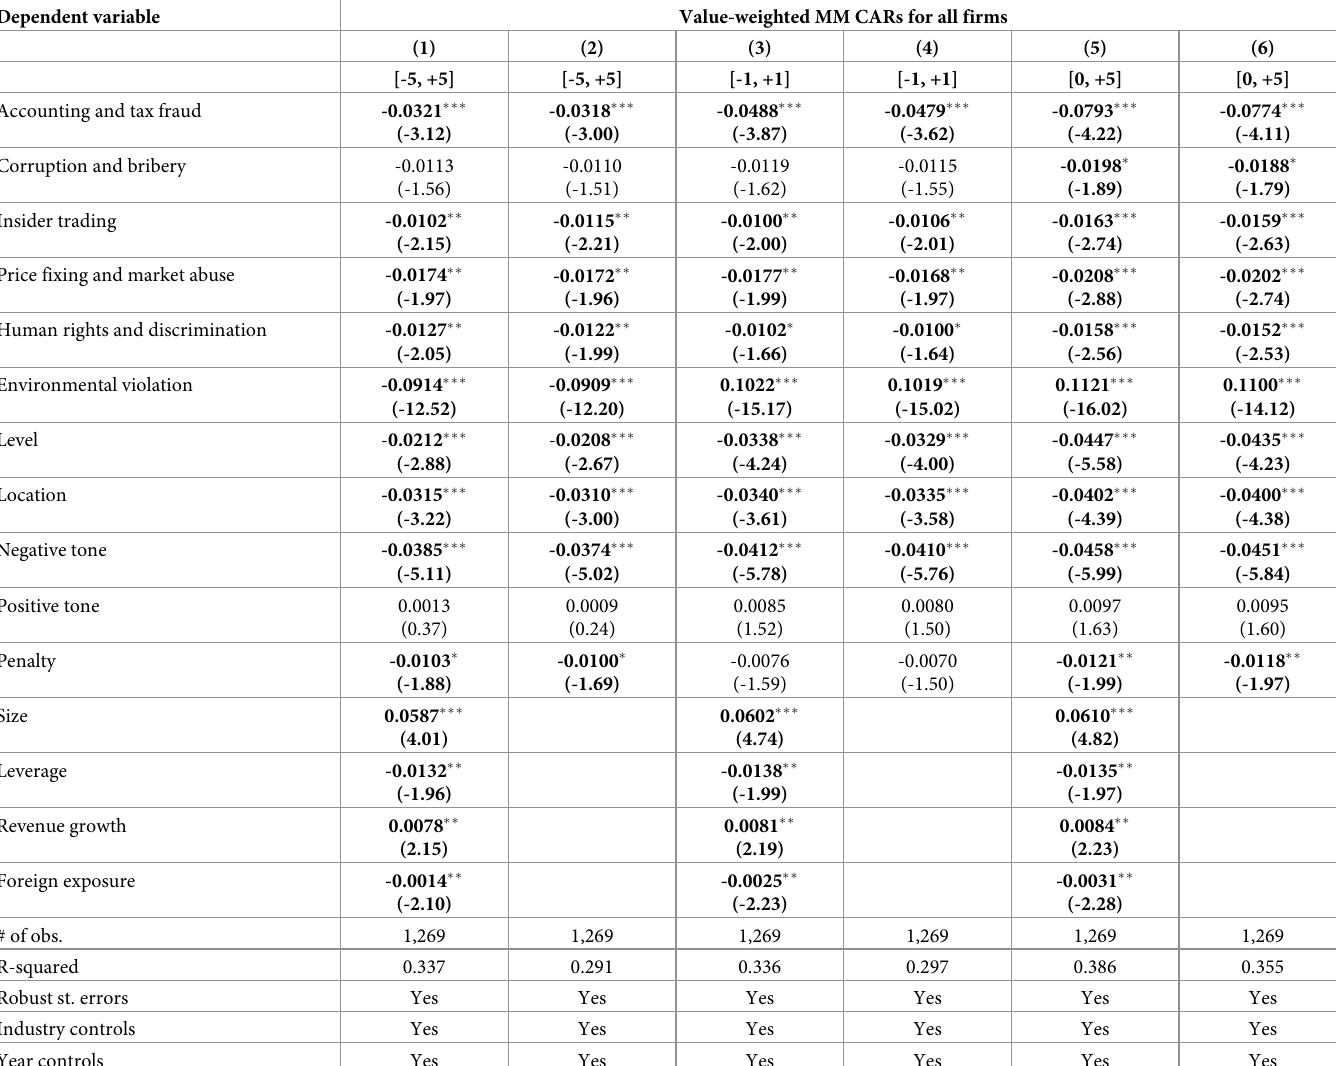
Table 2. The impact of the reported corporate misconduct events on the